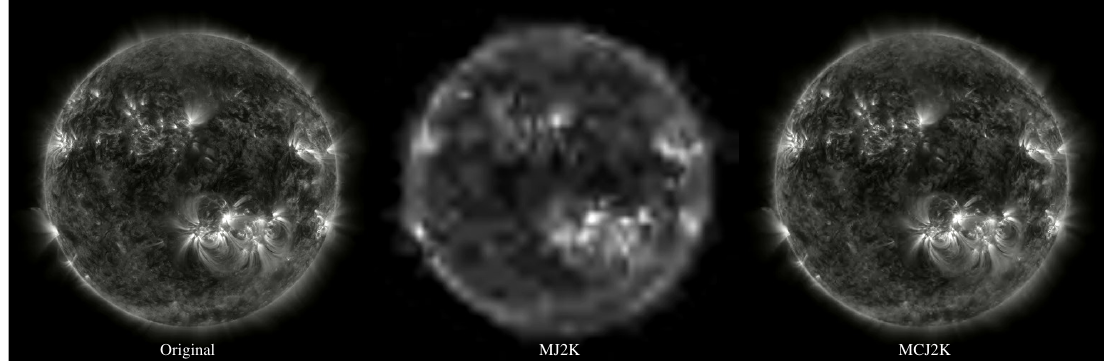
Figure 2. Reconstruction of one image of a sequence of Sun images using MJ2K and MCJ2K. Left: original Sun image with 512 512 pixels and a cadence of 1 images/second. Center: same image 12 × (progressively) decompressed with MJ2K at 0.08 kbps. Right: same image (progressively) decompressed with MCJ2K at 0.04 kbps. Image credit: